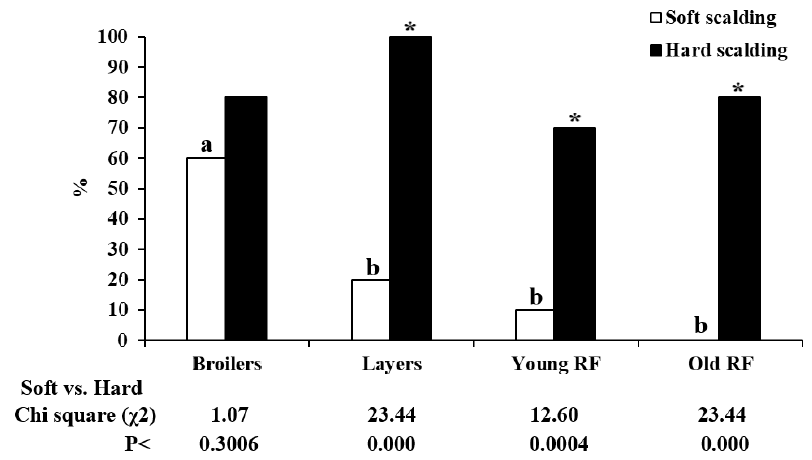
Figure 2. The typical carcass morphology of defeathering scores of young Red Feather country chickens. The scores of each part (neck, body, wings, legs, and tail) of individual bird were com- bined to produce a total with a range from a minimal score 5 to 15 for maximum. A typical carcass morphology with total scores of 15, 9, or 5 is shown.